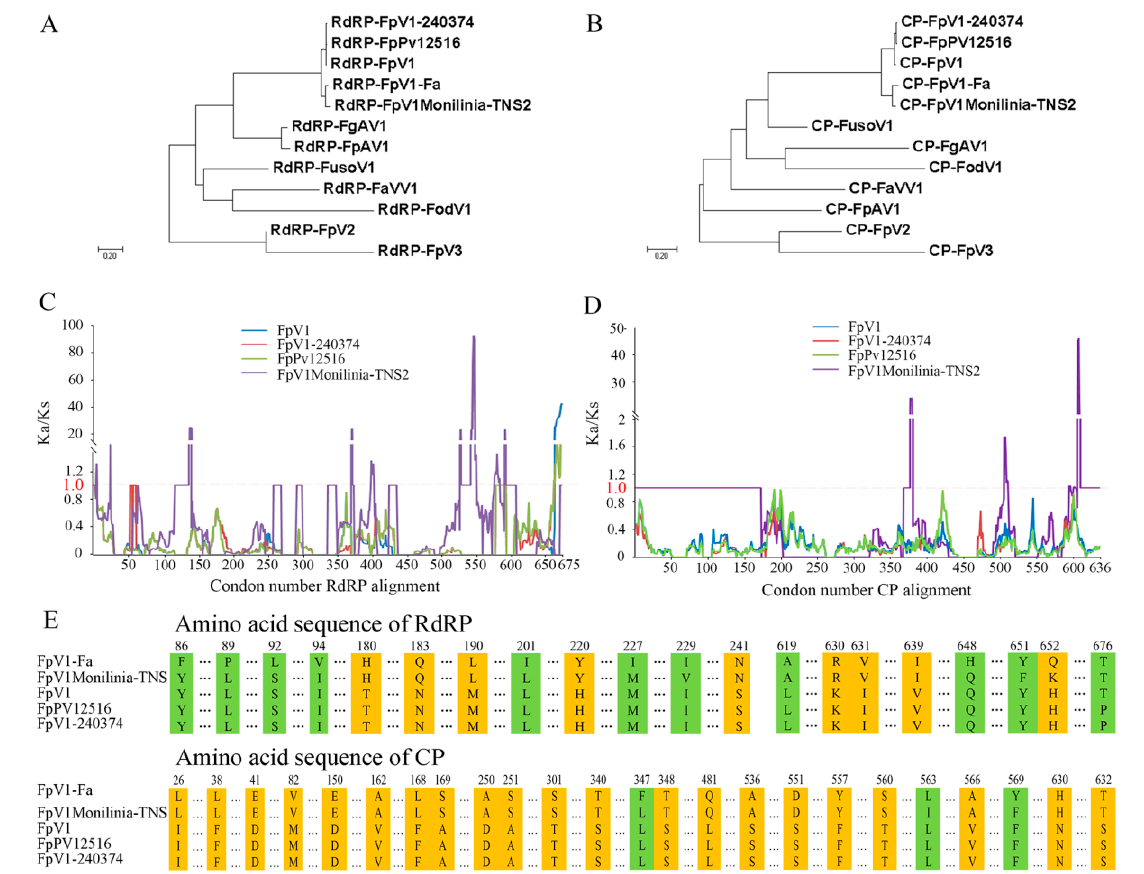
Figure 4. Phylogenetic analysis, sliding window analysis and amino acid sequence alignment of FpV1-Fa with other mycoviruses. Phylogenetic analysis of FpV1-Fa and related RNA viruses based on the RdRP ( A ) and CP ( B ). The phylogenetic tree is generated by the Clustal W program. The scale bar at the lower left represents a genetic distance. The GenBank accession numbers are as follows: RdRP-